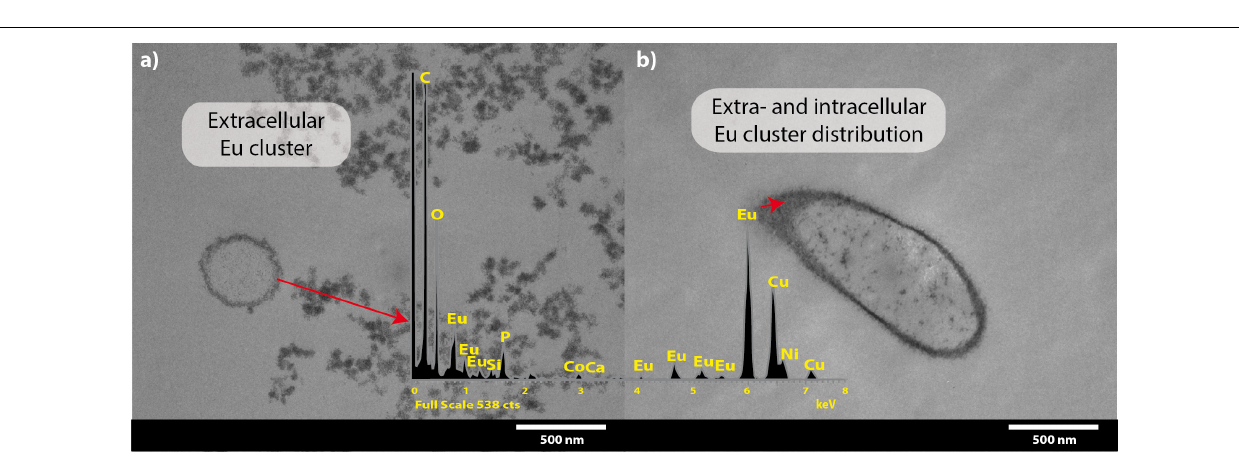
FIGURE 4 | Transmission electron microscopy micrographs of T. scotoductus SA-01 amended with 0.5 mM Eu. White bars indicate the scale in nanometers and red arrows show the location and distribution of Eu (shown as electron-dense granules). Europium biosorption (a) and intracellular bioaccumulation (b) . Insets show energy-dispersive X-ray